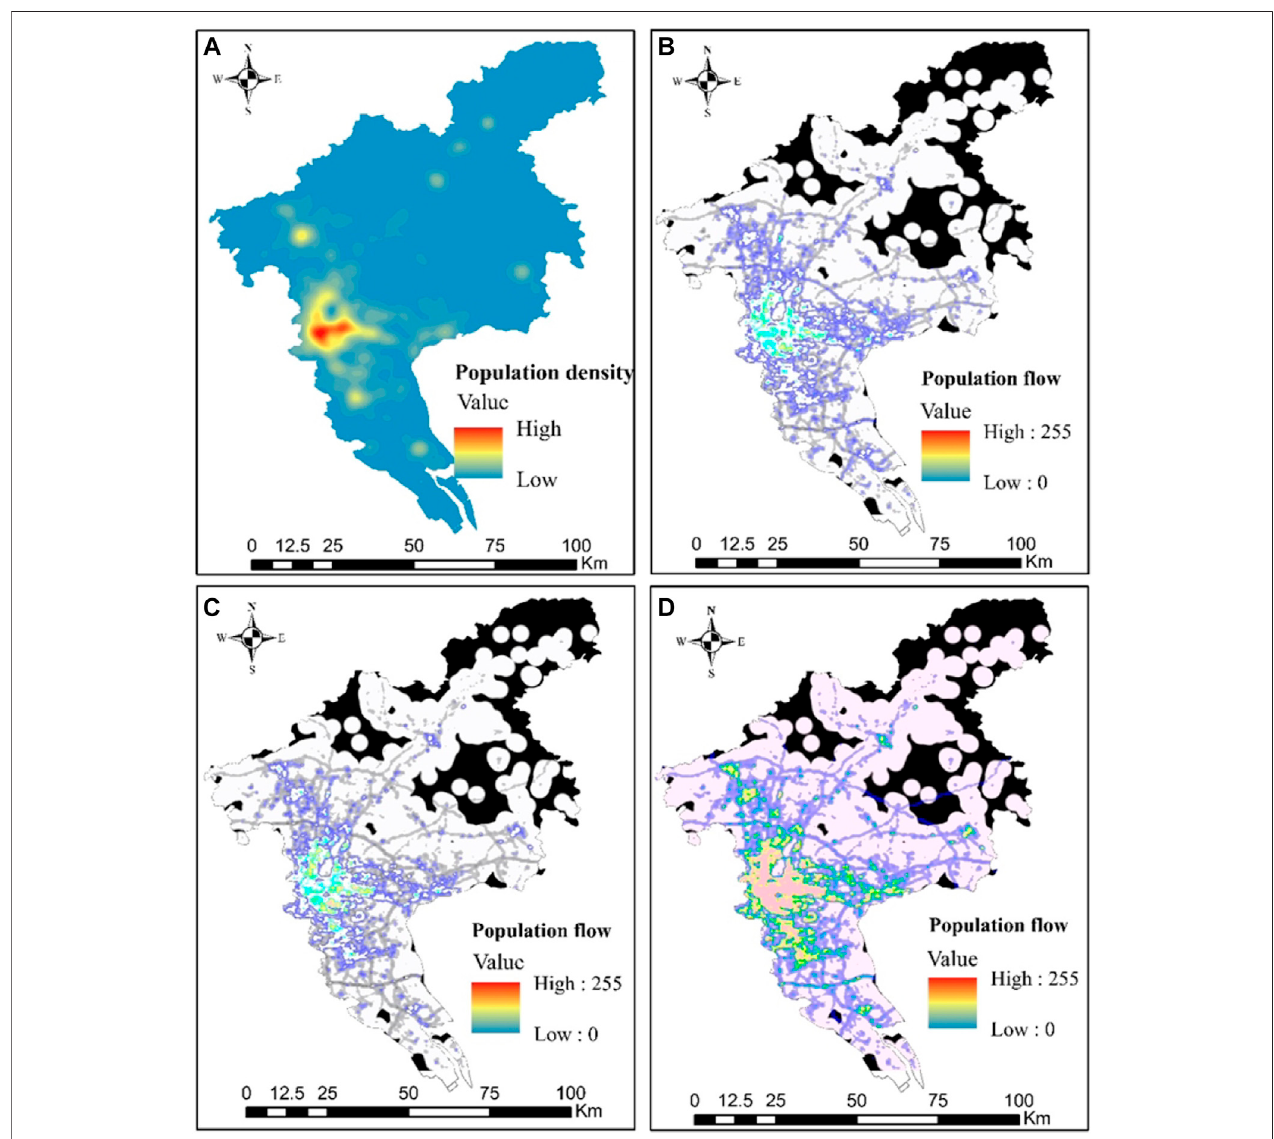
FIGURE3| Populationdatapreprocessingresults[ (A) PopulationdensityrepresentsthepermanentpopulationdensityofGuangzhouin2019; (B – D) representthe monthlyaveragedataofTencentpopulation migrationinJanuary,February, and Augustof2020inGuangzhou, respectively,and thecolorinthe fi gureranges fromblue to red, indicating permanent population density and population migration index value ranges from low to high].